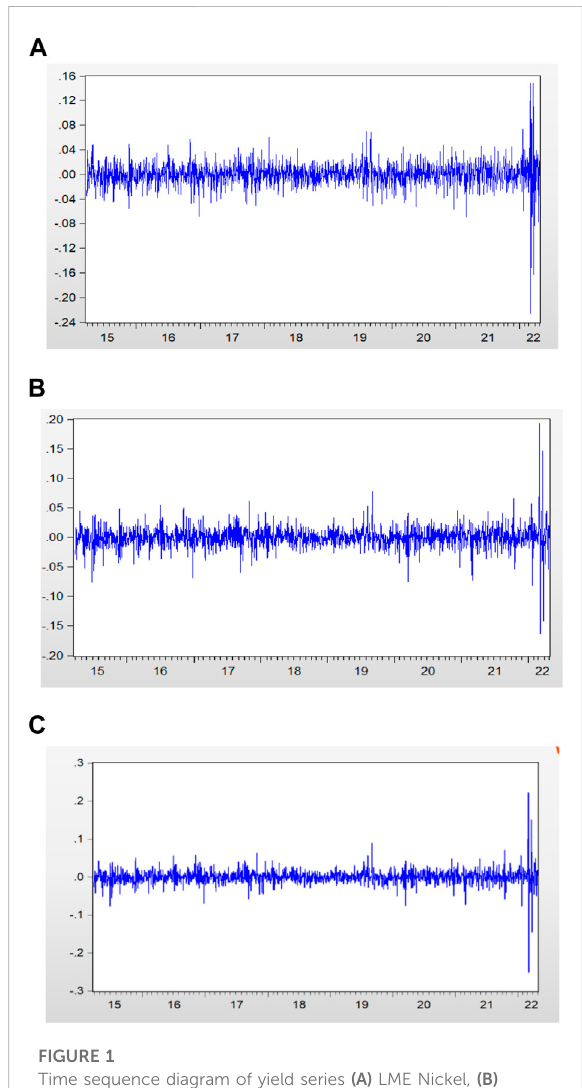
FIGURE 1 Time sequence diagram of yield series (A) LME Nickel, (B) SMM Nickel, (C) The spot